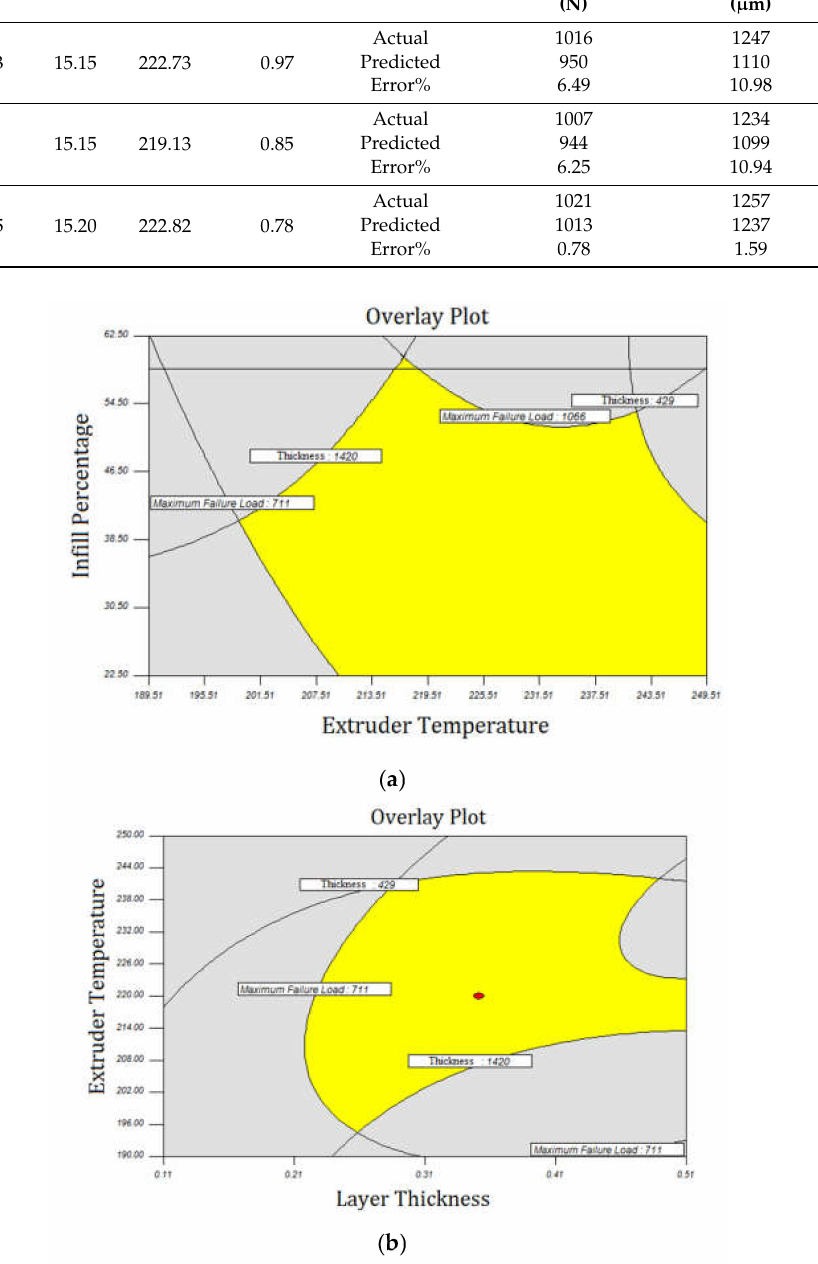
Figure 13. Overlay plot of 3D printing optimization with ( a ) infill percentage and extruder temperature; ( b ) extruder temperature and layer